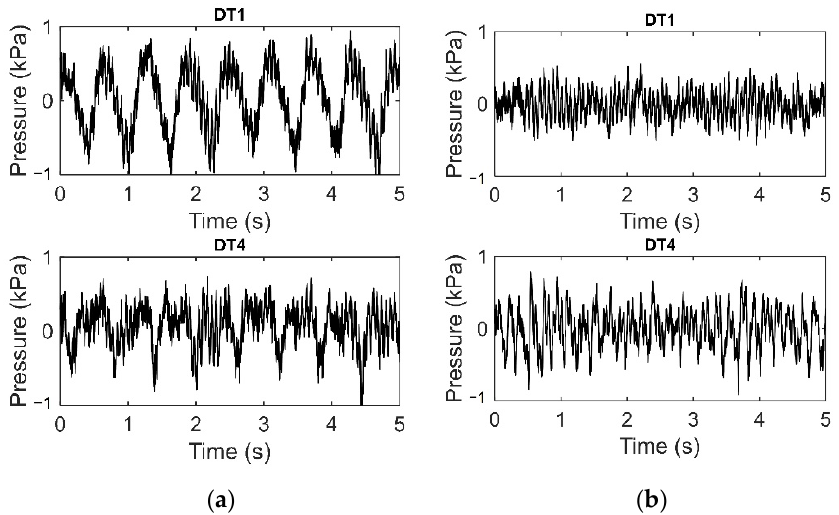
Figure 7. Pressure signals at PL1 operating condition for ( a ) draft tube with no GV and ( b ) with 0 GV.